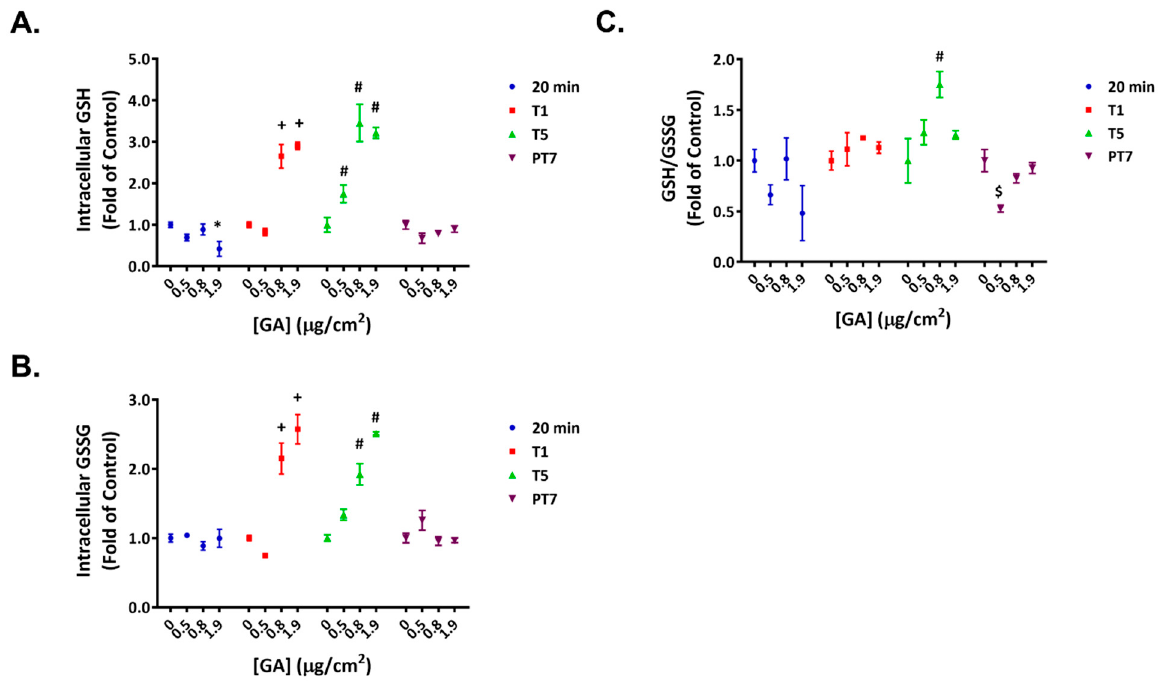
Figure 3. Temporary disruption of GSH/GSSG redox balance by GA aerosols. Intracellular levels of GSH ( A ) and GSSG ( B ) were quantified 20 min after the first exposure (20 min) and at T1, T5, and PT7. Normalized ratios of GSH/GSSG ( C ) were calculated for the respective timepoints. Data ( n = 3) are presented as means ± SEM. * ,+,#,$ p < 0.05 was considered statistically significant when compared to the respective vehicle controls.